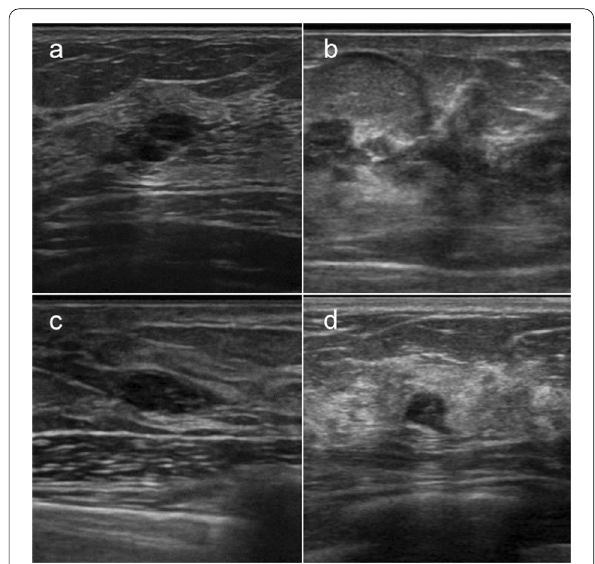
Fig. 2 Ultrasonographic image. a Dilated duct collection on Case 1. b Distortion on Case 2. c A circumscribed lobulated hypoechoic mass on Case 3. d A microlobulated irregular hypoechoic mass on Case